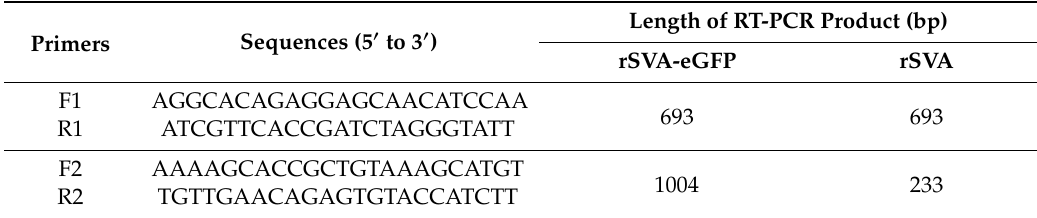
Table 1. Two pairs of primers for RT-PCR analyses on enhanced green fluorescent protein-tagged recombinant SVA (rSVA-eGFP).